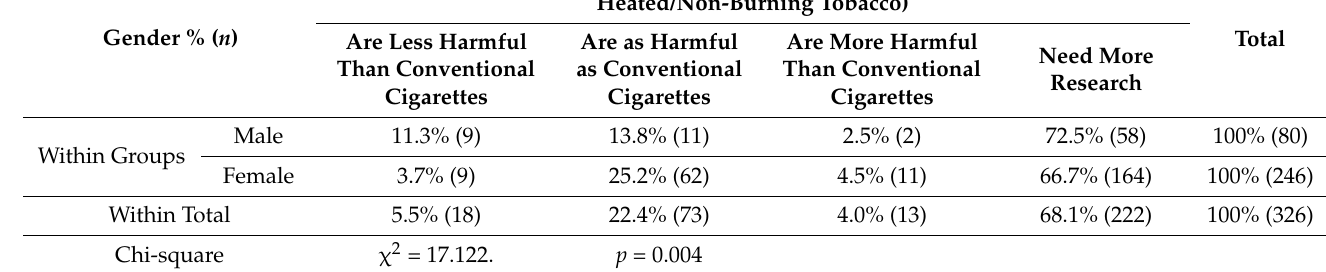
Table 6. New forms of tobacco/nicotine consumption.